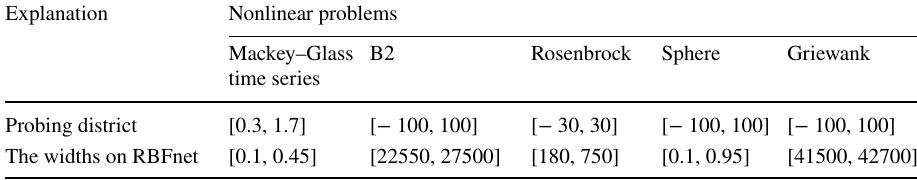
Table 1 The parameter sets for five nonlinear